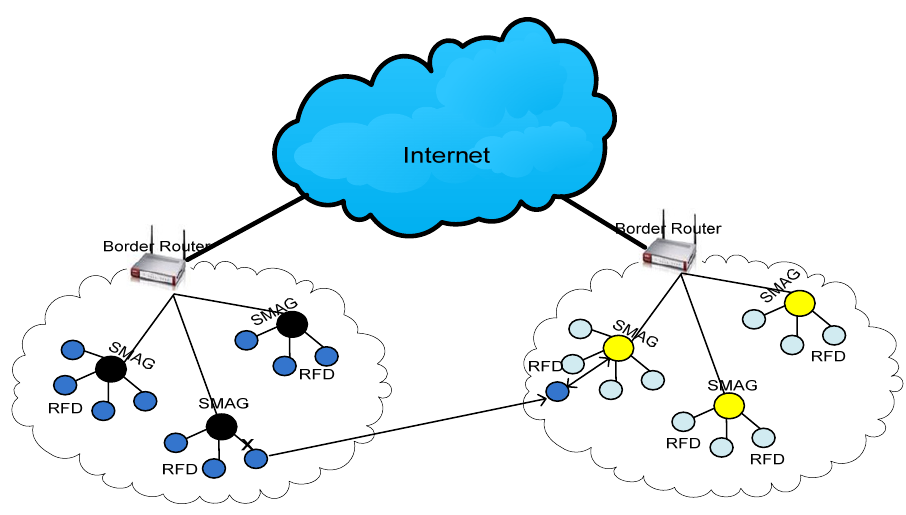
Figure 8. Inter-SMAG communication under different border router.